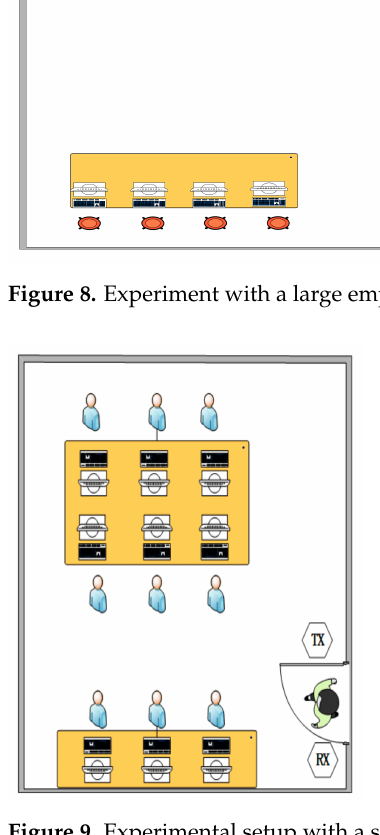
Figure 9. Experimental setup with a small office room.